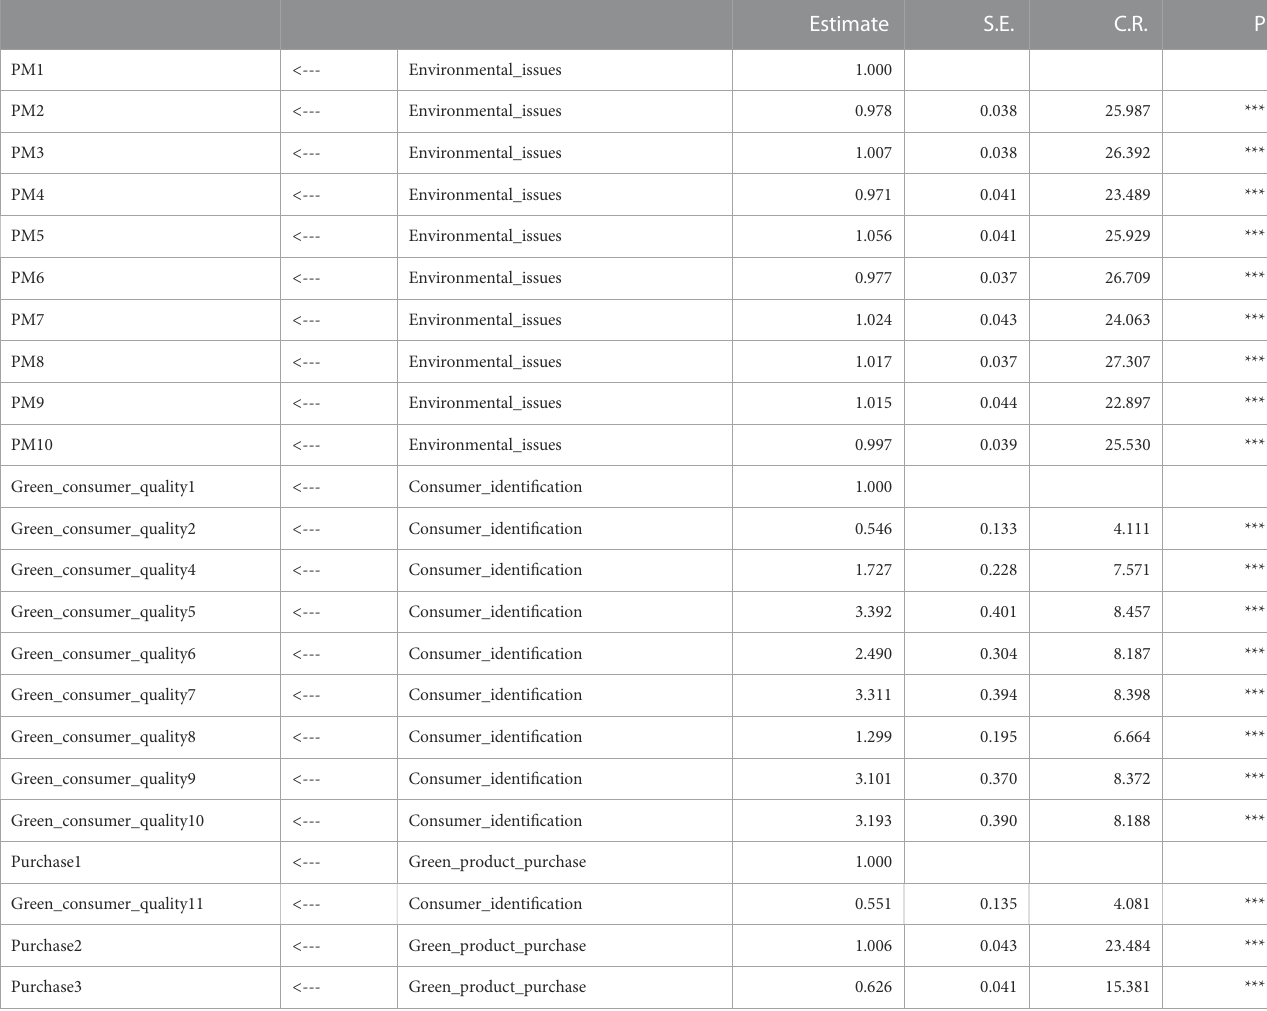
TABLE 8 ( Continued ) Regression Weights: (Group number 1 - Default